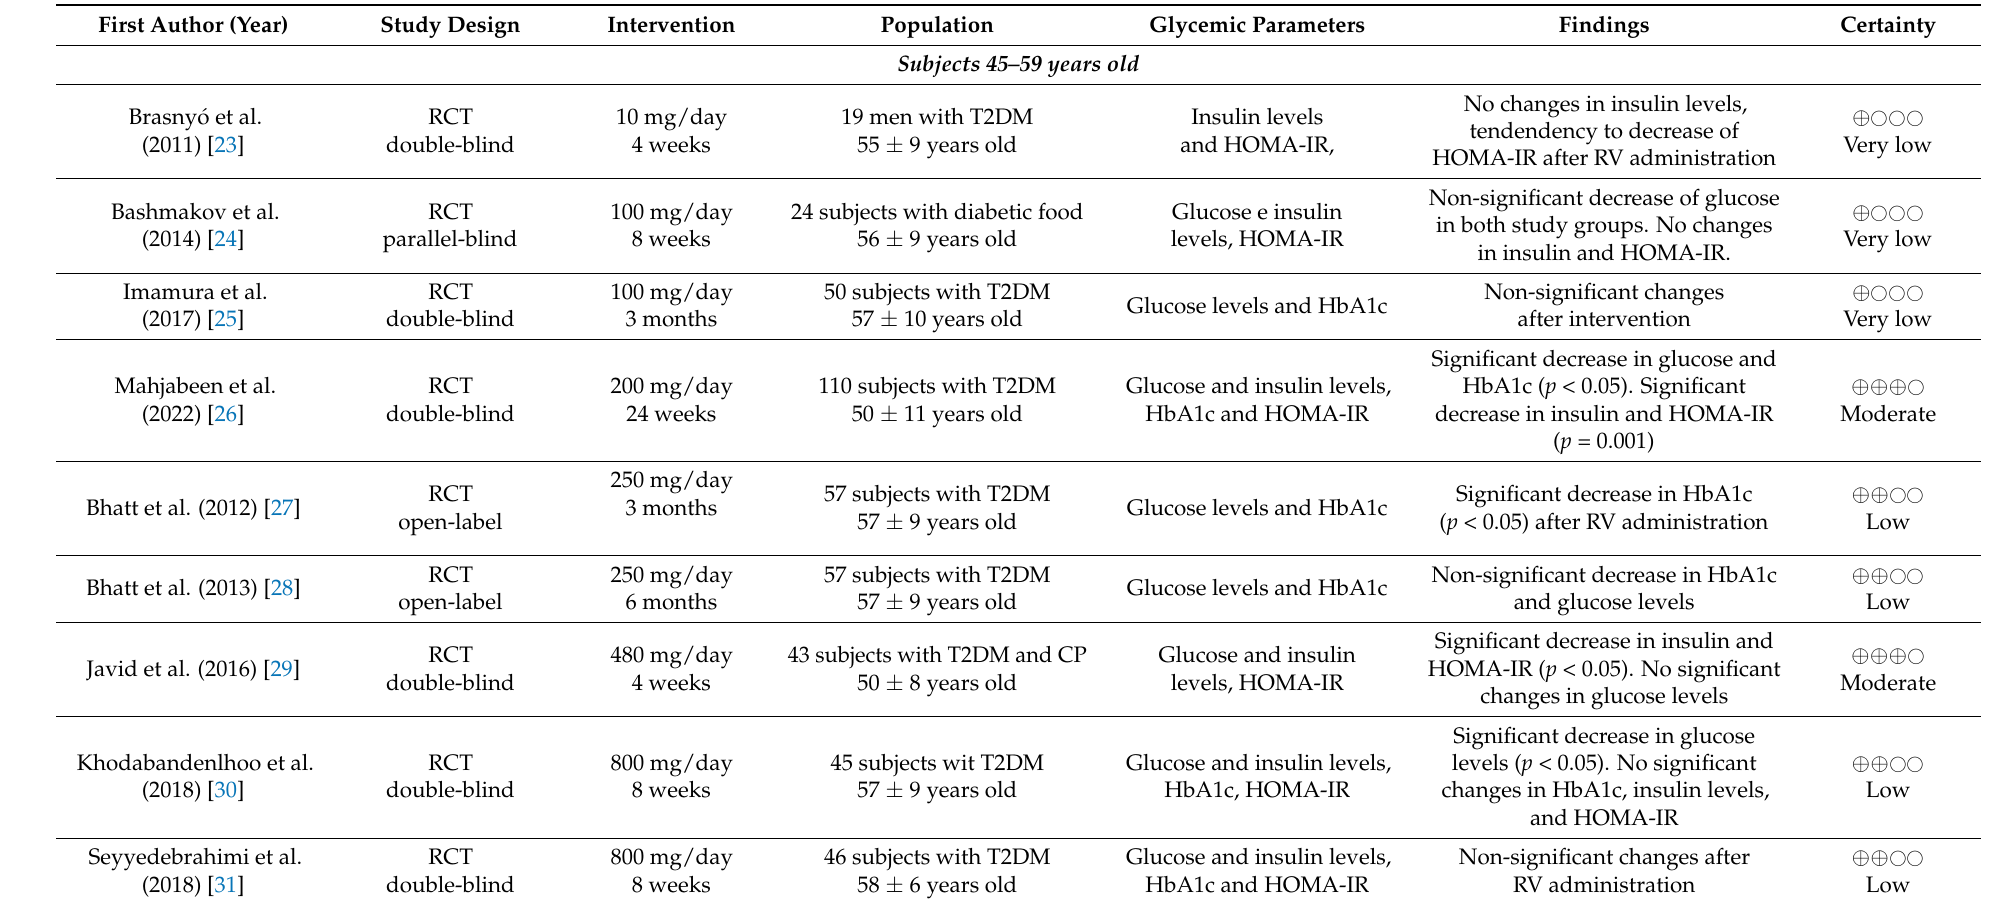
Table 1. Characteristics of clinical trials included in the